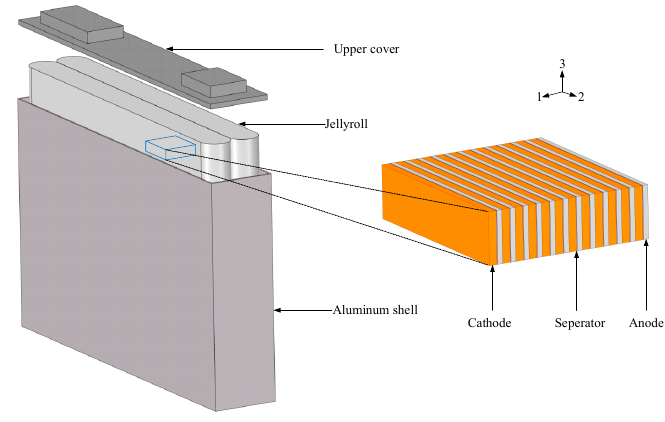
Figure 5. Composition of the prismatic cell.